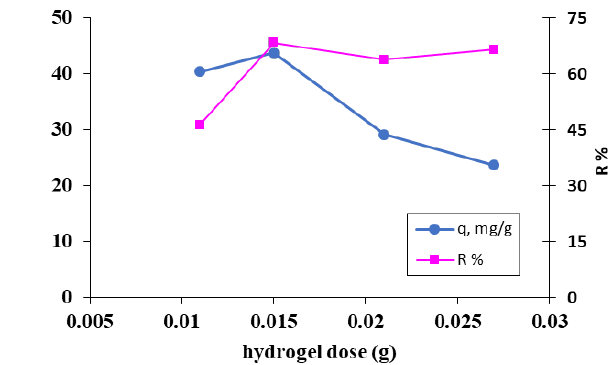
Figure 6. The influence of biosorbent dose on the retention of the MB cationic dye on the OxC25 hydrogel. Operational conditions: C 0 = 38.4 mg/L; pH = 11; T = 20 °C.